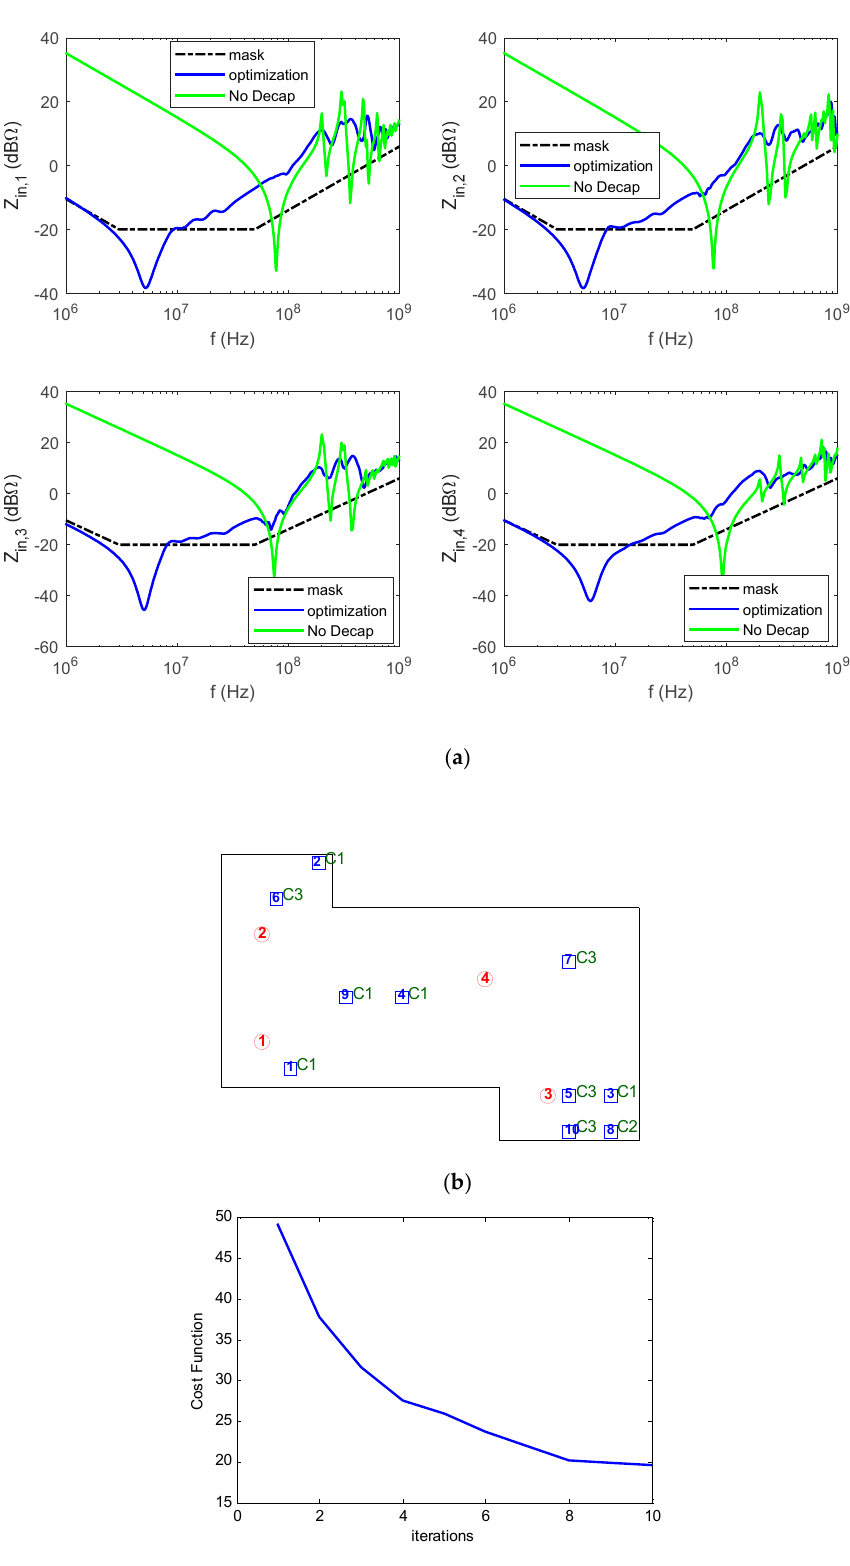
Figure 10. Optimization results after running the combined ANN-GA process for the placement of 10 decaps. ( a ) input impedances at the four ports, ( b ) decap placement with the identification of the capacitor type listed in Table 1, ( c ) Decreasing trend of the cost function.